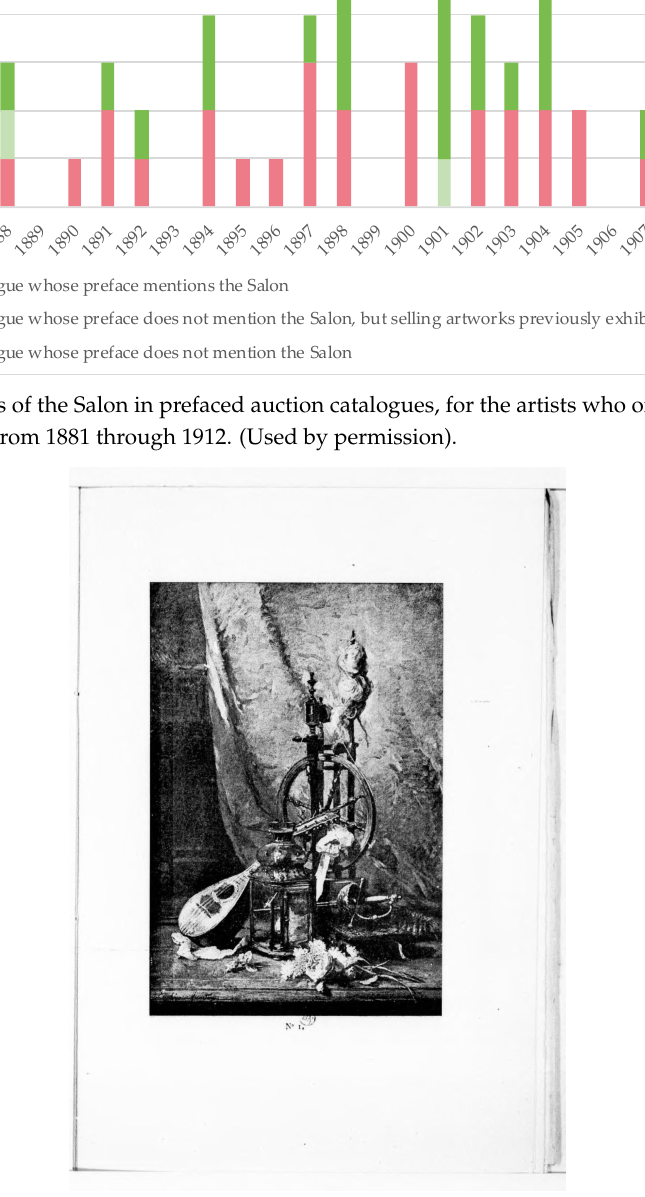
Figure 6. Euphémie Muraton, Old Memories , oil on canvas, 130 cm × 90 cm, reproduced in the auction catalogue of her works, 26 March 1888, opposite p. 10. (Used by